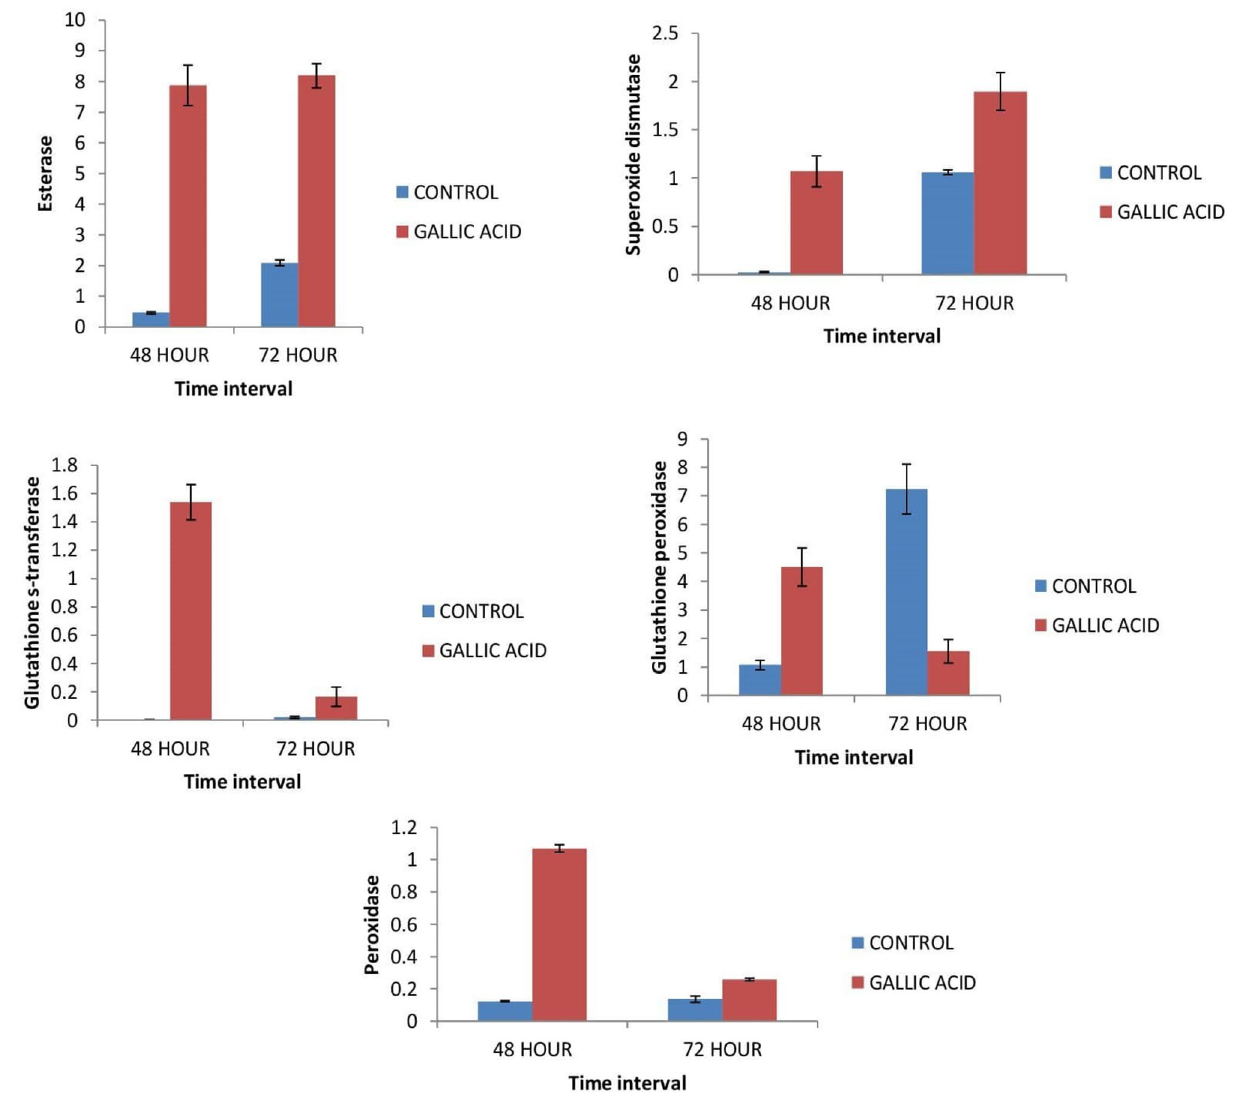
Figure 3. Effect on the expression (Means ± S.E) of different antioxidant genes (EST, SOD, GST, GPOX and POX) of S. litura larvae treated with artificial diet amended with and without gallic acid.